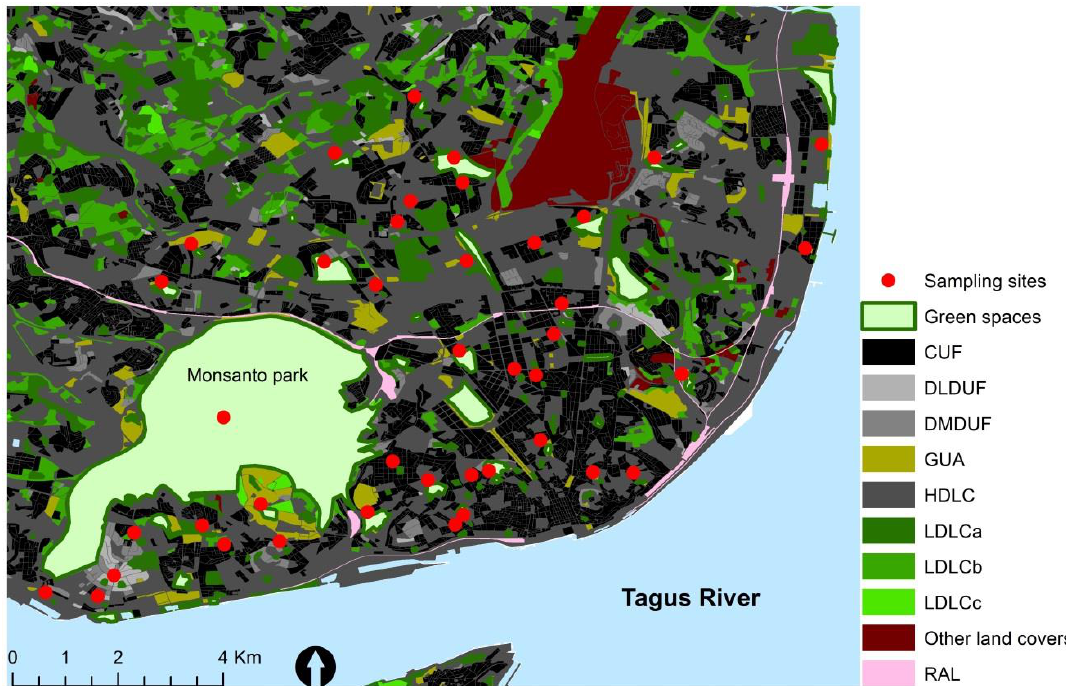
Figure 1. Study area showing the distribution of the sampling sites (red circles; n = 41) within the green spaces and the city’s land covers (adapted from Urban Atlas 2012). Green Spaces; CUF - Continuous urban fabric (S.L.: >80%); DLDUF—Discontinuous low density urban fabric (S.L.: 10%–30%); DMDUF—Discontinuous medium density urban fabric (S.L.: 30%–50%); GUA—Green urban areas; HDLC—High disturbance land covers; LDCLa—Low disturbance land covers (1000 m buffer); LDCLb—Low disturbance land covers (1500 m buffer); LDCLc—Low disturbance land covers (2000 m buffer); Other land covers and RAL—Railways and associated land. Monsato Forest Park is the biggest green space present in our study area.